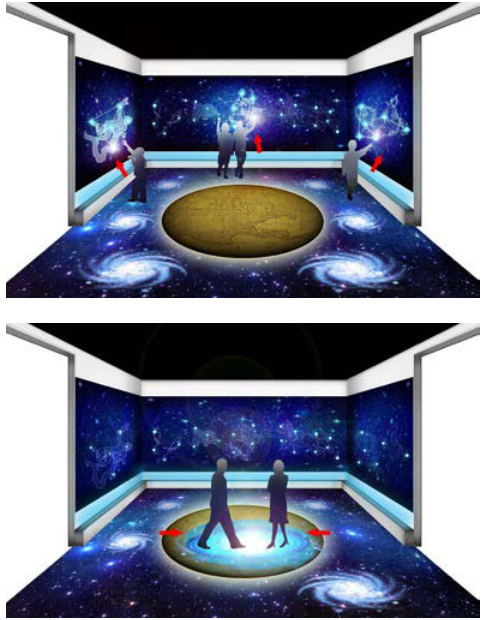
Figure 7. Simulated images demonstrate how participants walking on nebulas. When two participants run into each other a massive explosion of star cloud is